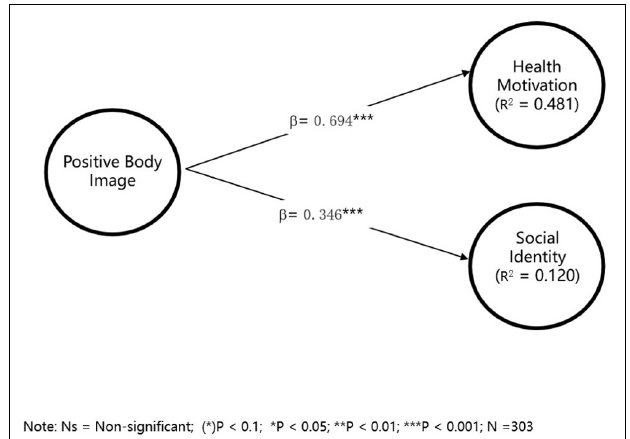
FIGURE 3 | PLS regression results for the dual nature